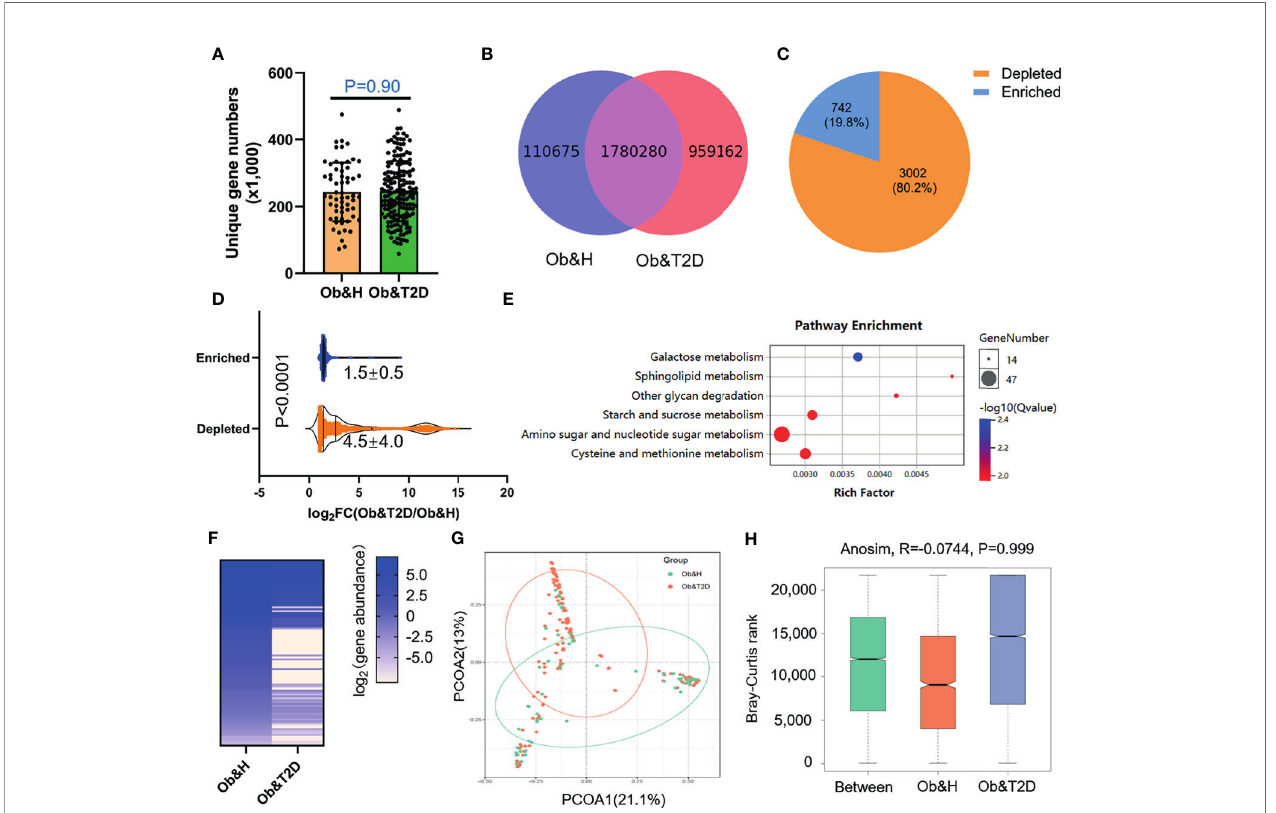
FIGURE 4 | Differential gut microbial gene functions annotation on Kyoto Encyclopedia of Genes and Genomes (KEGG) in obese and healthy (Ob&H) and obese and type 2 diabetes (Ob&T2D). (A) Box plots show the number of observed gut microbial unique genes in Ob&H and Ob&T2D. Data are shown as means ± SD. The P - value is from Wilcoxon rank-sum tests. (B) Venn diagrams demonstrate the number of unique genes shared between Ob&H and Ob&T2D. (C) The pie chart displays the number of enriched or depleted genes ( fi ltering criteria: q -value <0.1, at least twofold change) in Ob&T2D compared with Ob&H. (D) Violin plots display the changing fold of enriched or depleted genes. Data are shown as means ± SD. The P -value is from Wilcoxon rank-sum tests. (E) Representative gene ontology enrichment ( q -value <0.05) analysis of 3,002 depleted genes in Ob&T2D. (F) Heat map depicting the log 2 (gene abundance) of 96 representative genes involved in the enriched KEGG pathways in (E) . (G) Principal coordinate analysis based on the Bray – Curtis distance of 96 depleted gene abundance between Ob&H and Ob&T2D. (H) Comparison of the enriched KEGG orthologous between Ob&H and Ob&T2D. ANOSIM, R = − 0.0744, P =